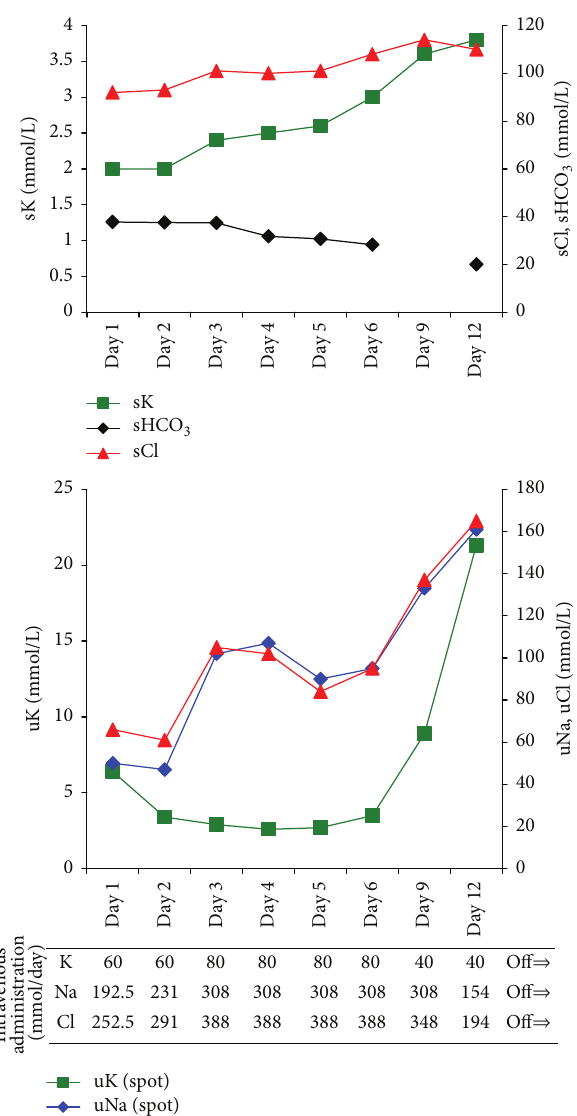
Figure 1: Clinical course. sCl, serum chloride; sHCO 3 , serum bicar- bonate; sK, serum potassium; uCl, urinary chloride; uK, urinary potassium; uNa, urinary